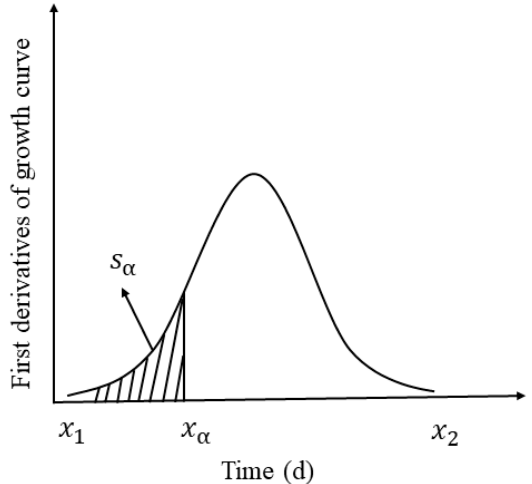
Figure 6. Schematic diagram of percentile points.